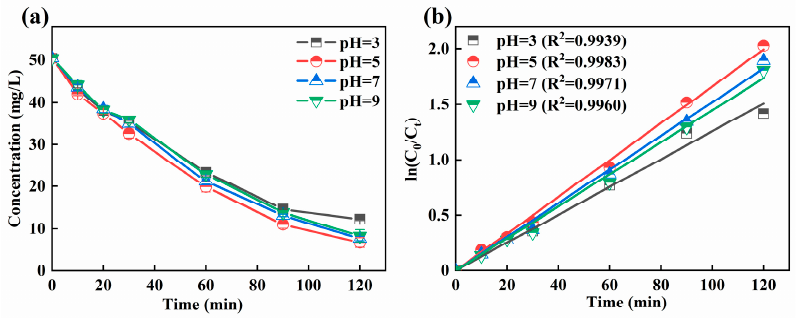
Figure 2. Decomplexation of Ni-EDTA with different pH values ( a ) and kinetics fitting lines ( b ). Table 1. Some typical 3D-EF works at different pH values.